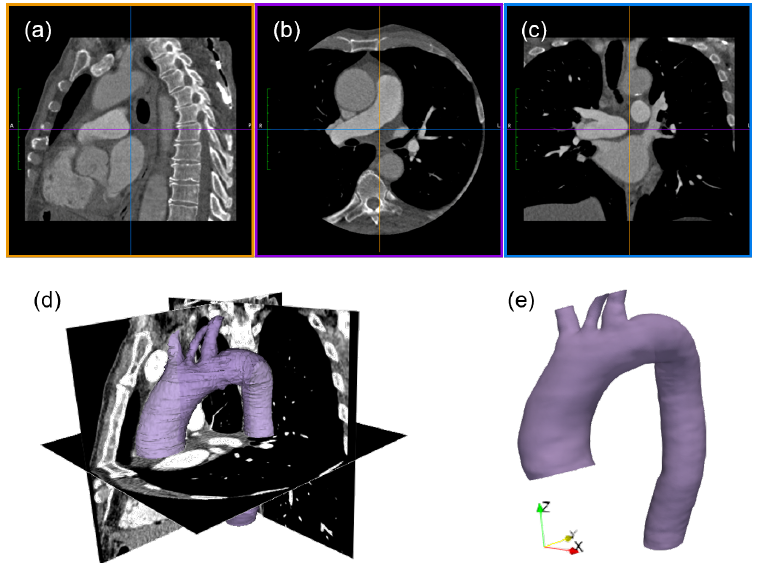
Figure 1. CT imaging processing: sagittal ( a ), axial ( b ), and coronal ( c ) planes of CT dataset, raw segmentation result ( d ), and refined model of the aorta ( e